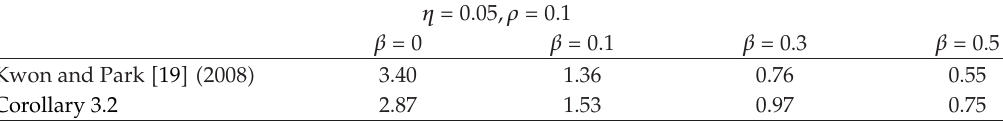
Table 2: Upper bounds of time delays in Example 4.3 for various conditions.